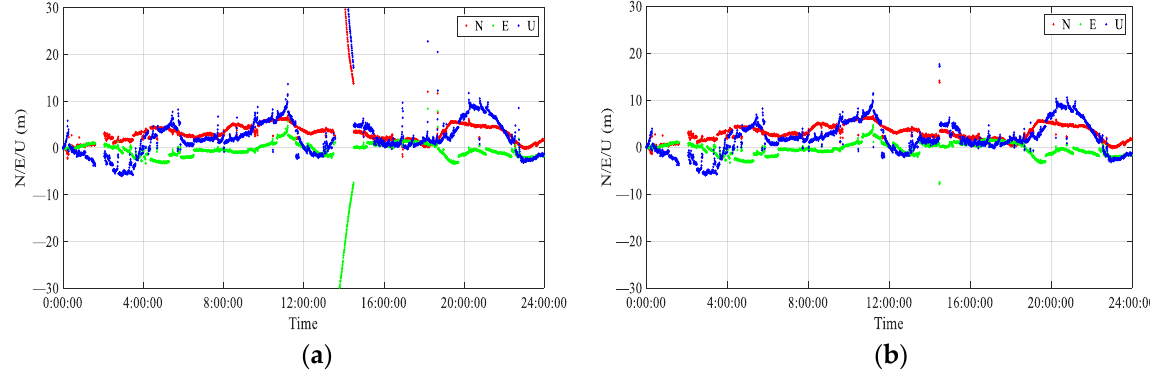
Figure 11. Time series of N, E and U directions of BRMG station based on BI1 and B3I observation data before (a) and after (b) blunder error detection.